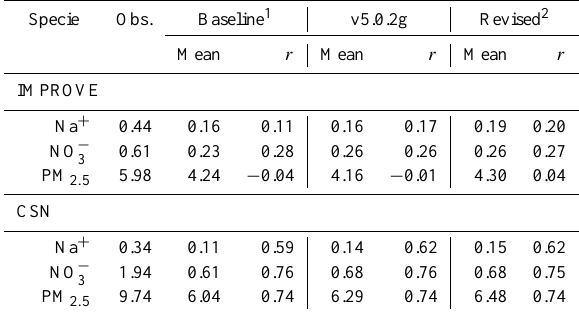
Table 3. Statistical comparison of the mean and Pearson’s correla- tion coefficient ( r ) between observed and model-predicted sodium, nitrate and PM 2 . 5 surface concentrations (µgm − 3 ) for the continen- tal US in May 2002 from the IMPROVE and CSN